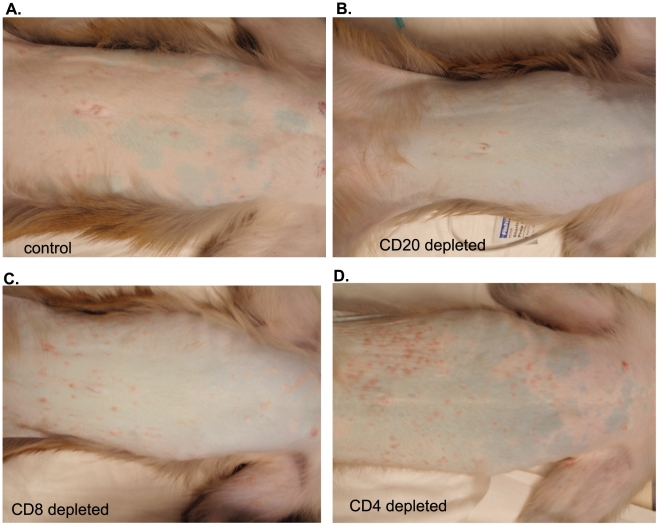
Representative examples of varicella in control and depleted animals.Varicella rash on the trunk of a representative (A) control, (B) CD20 depleted, (C) CD8 depleted, and (D) CD4 depleted animal at 10 dpi.